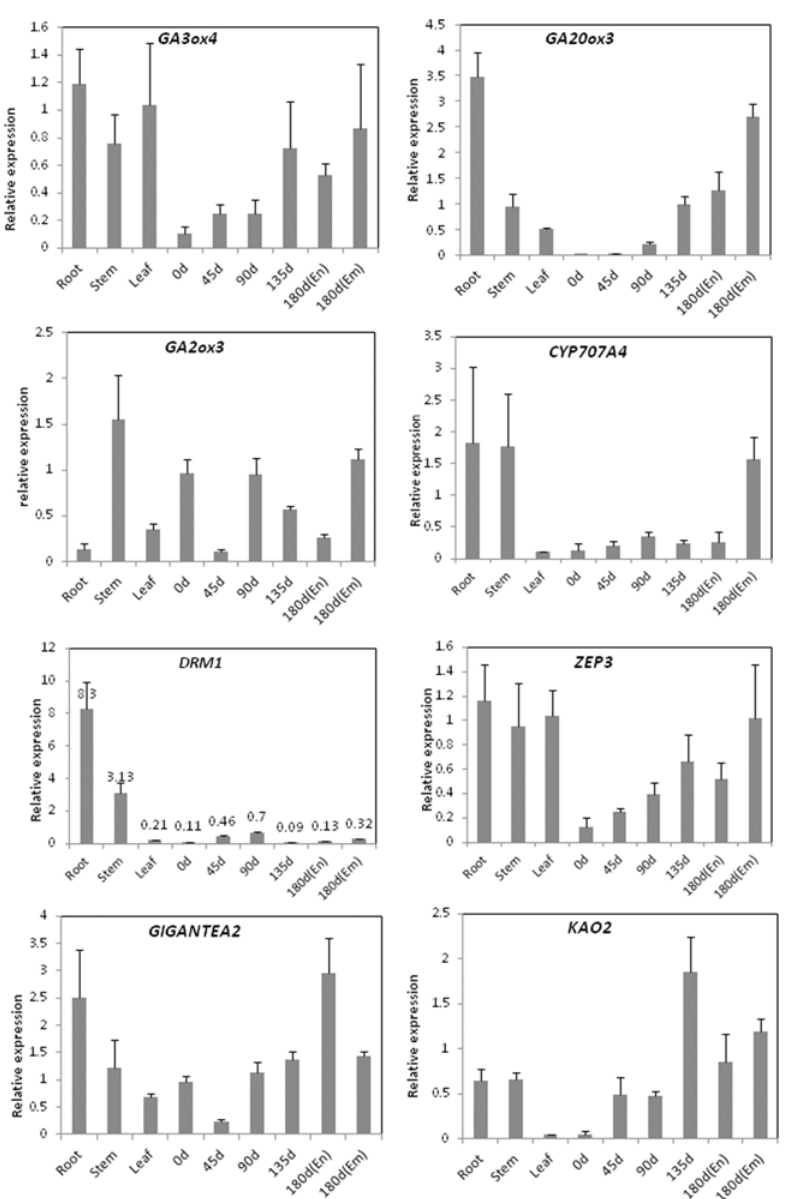
Fig 7. Relative expression level analysis of 8 selected genes. 0d, 45d, 90d, 135d, and 180d: cold seed stratification period;0d, 45d, 90d, 135d, and 180d: seed stratification period; Em: embryo; En: endosperm; root, stem, and leaf as control